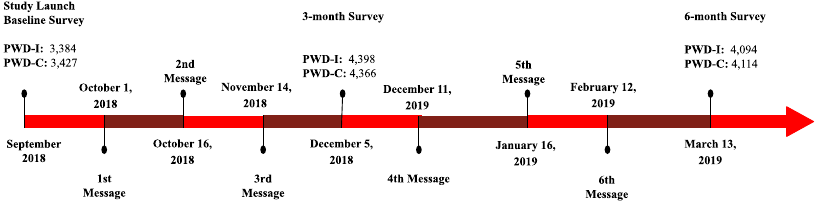
Fig. 2 Study fl ow and intervention delivery. Depicts the study fl ow for participants and the timing of the intervention messages. The timing of the surveys and the corresponding n participants who completed those surveys is also included. PWD-I People with diabetes-intervention group, PWD-C People with diabetes-control